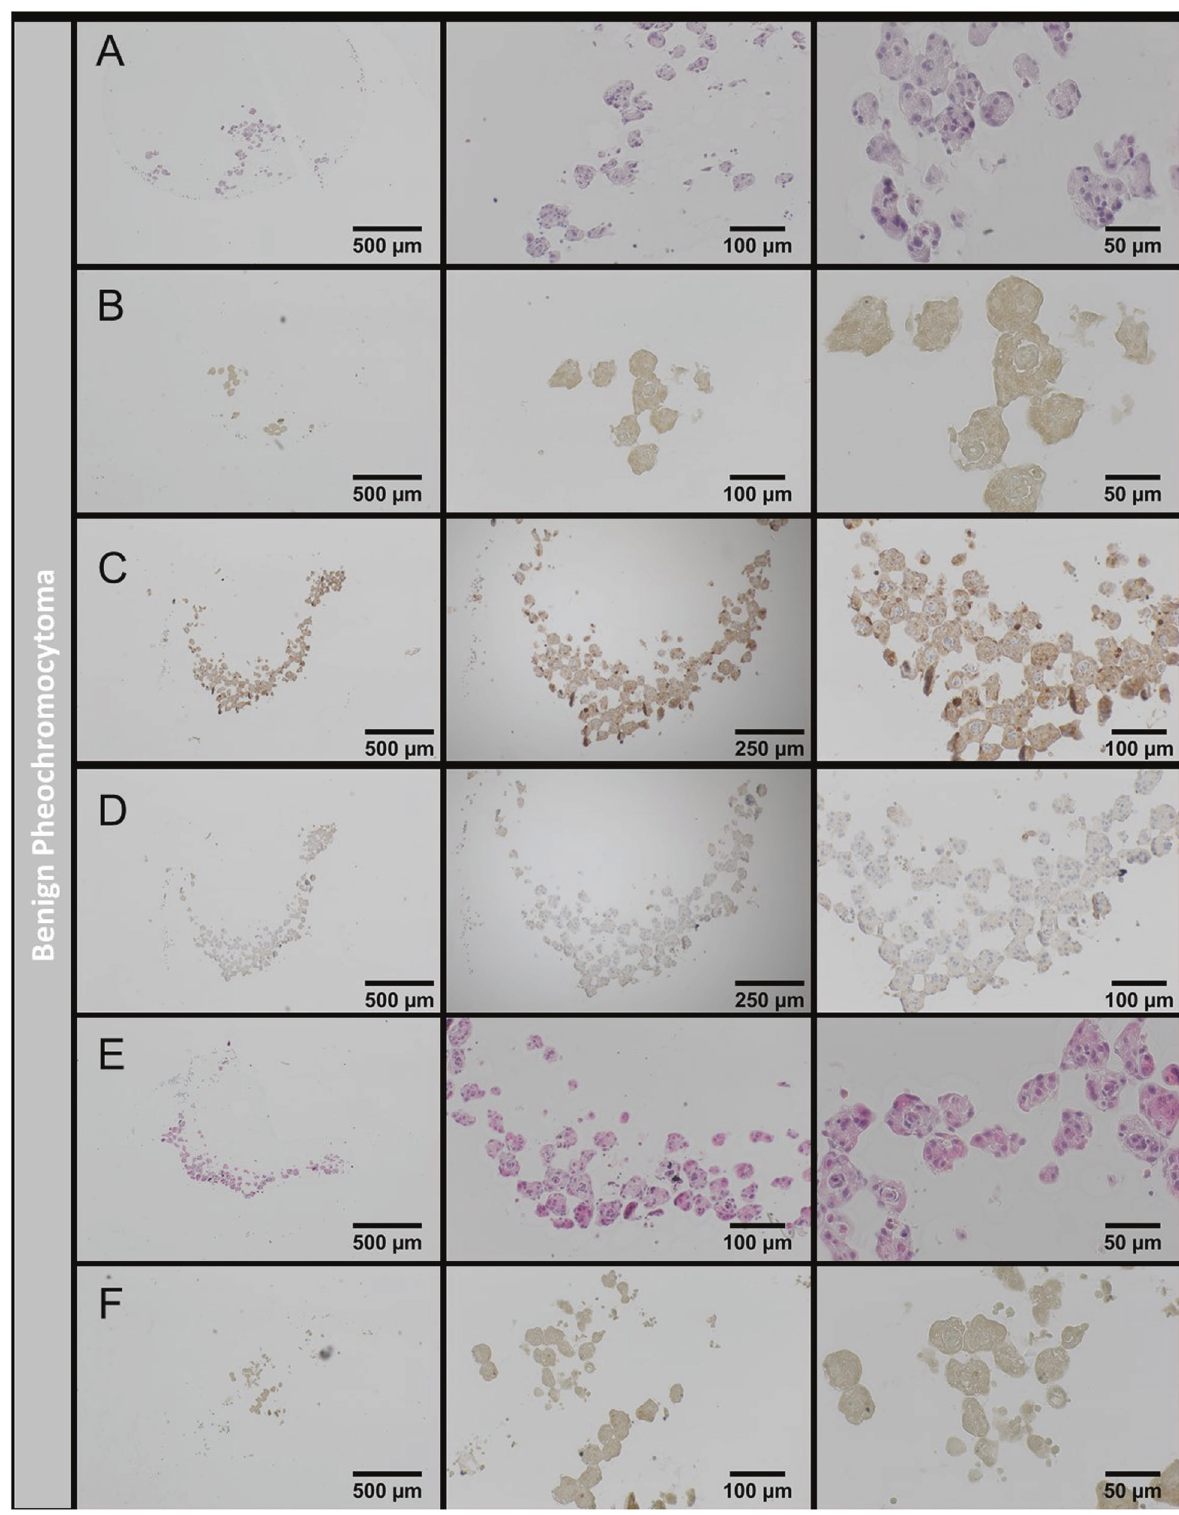
Fig. 5 Spheroid formation from benign pheochromocytoma. H&E staining of spheroids at 3 different magni fi cations A . Spheroids were analyzed with the proliferation marker Ki-67 B . Spheroids processed for chromogranin A C and its respective no-antibody control D . Spheroids treated with 25 µm Gemcitabine (H&E, E and Ki-67, F